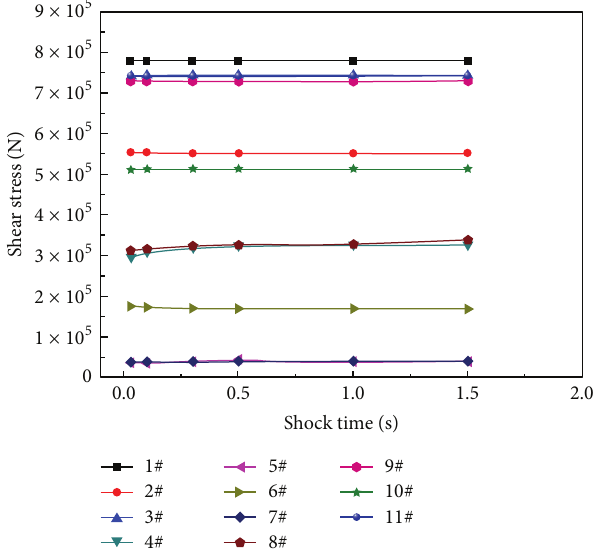
Figure 5: Shear stress curves with shock time of each bolt.